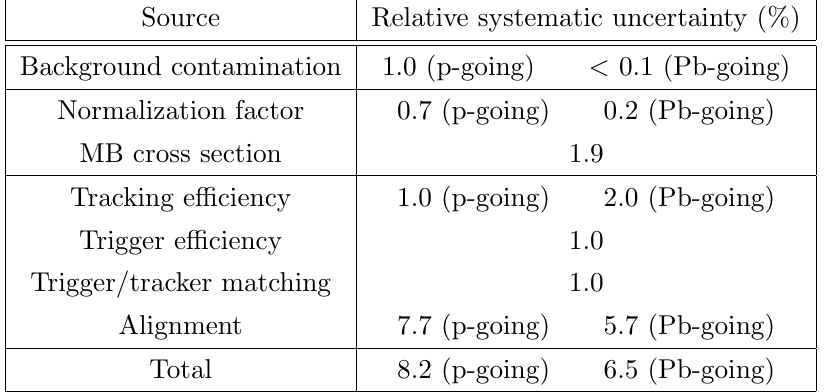
Table 1 . Components of the relative systematic uncertainties on the Z-boson yield and cross section in the p-Pb analysis. The uncertainties on the MB cross section and the alignment are partially correlated between p-Pb and